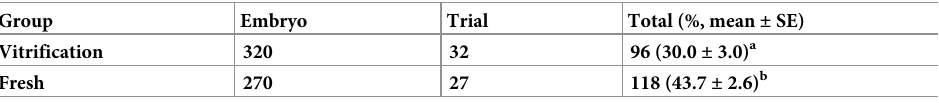
Table 1. Effect of vitrification on the embryonic developmental rate till the blastocyst stage.